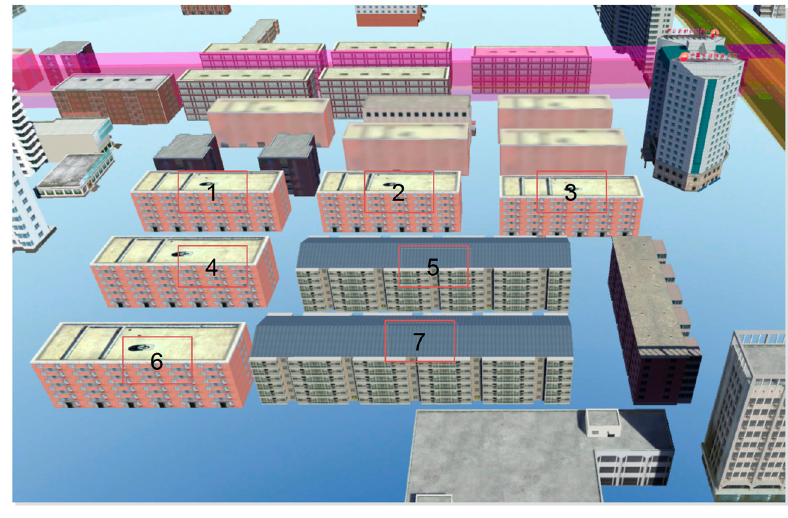
Figure 6. Texture features.